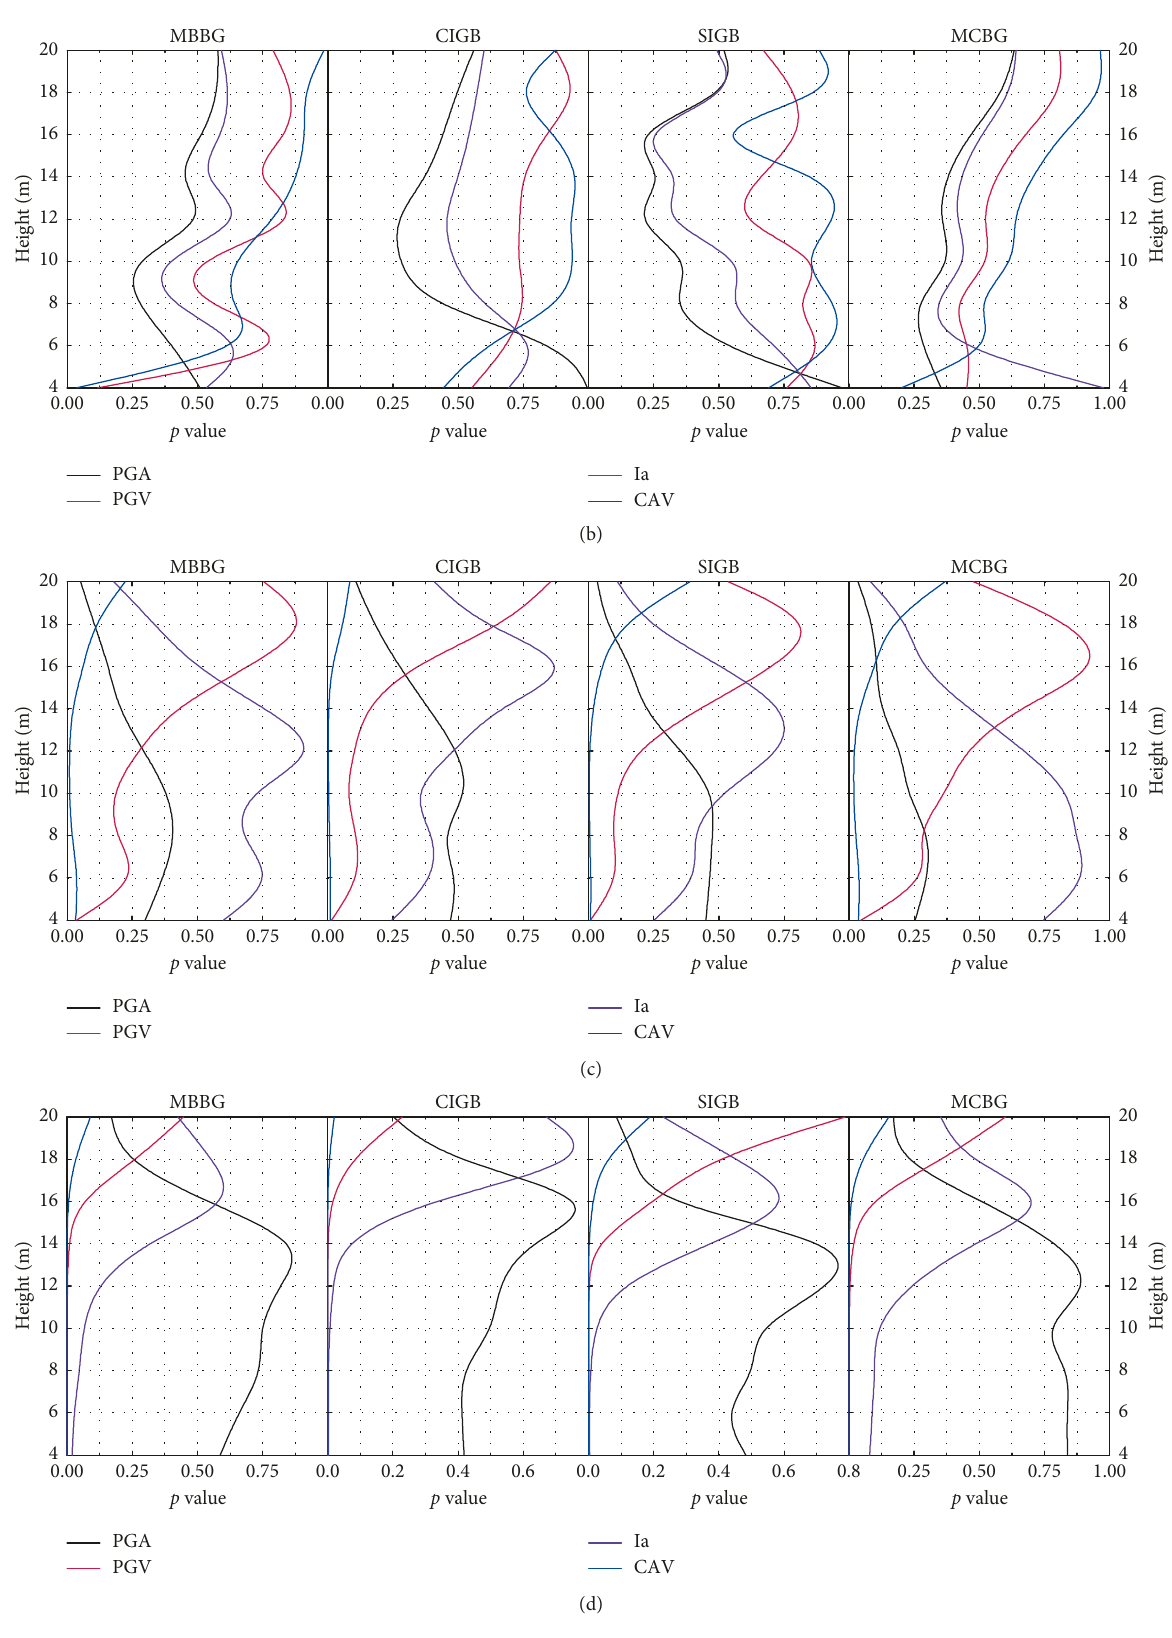
Figure 17: IMs sufficiency comparison with respect to M for (a) the pier curvature ductility along the longitudinal direction, (b) the pier curvature ductility along the transverse direction, (c) the bearing deformation along the longitudinal direction, and (d) the bearing deformation along the transverse